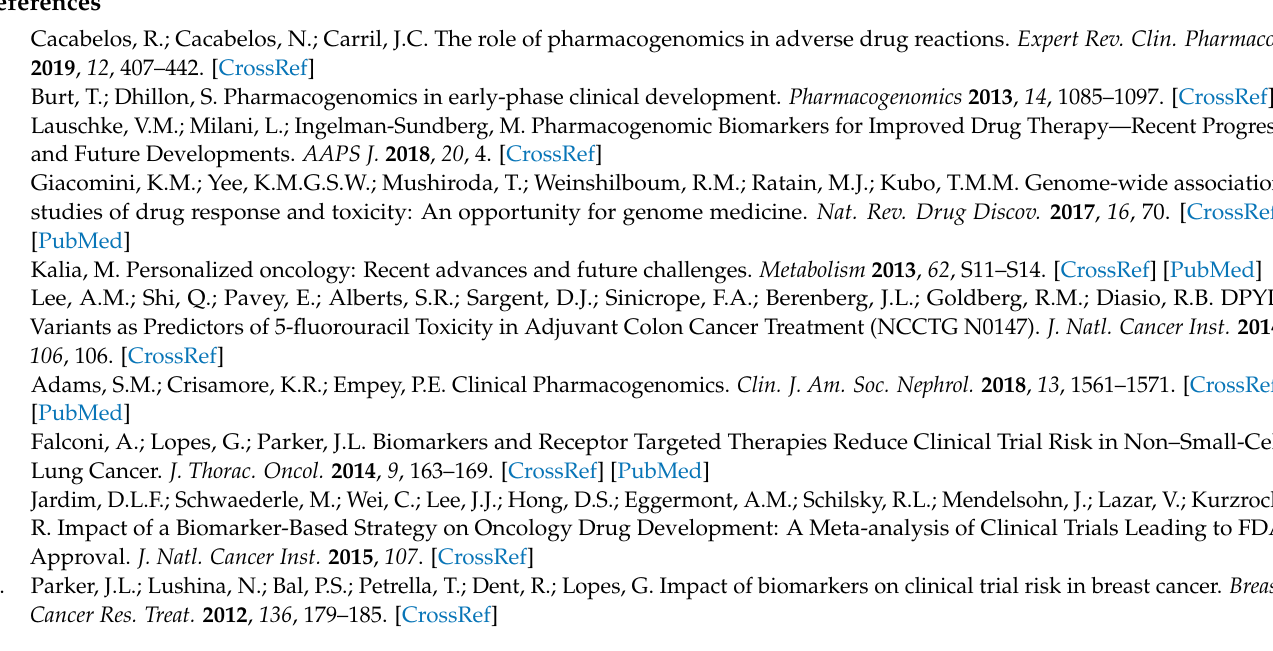
Figure A1. Trends in the number of new drug approvals with PGx labeling from 2000–2020. Data shown through July of 2020.